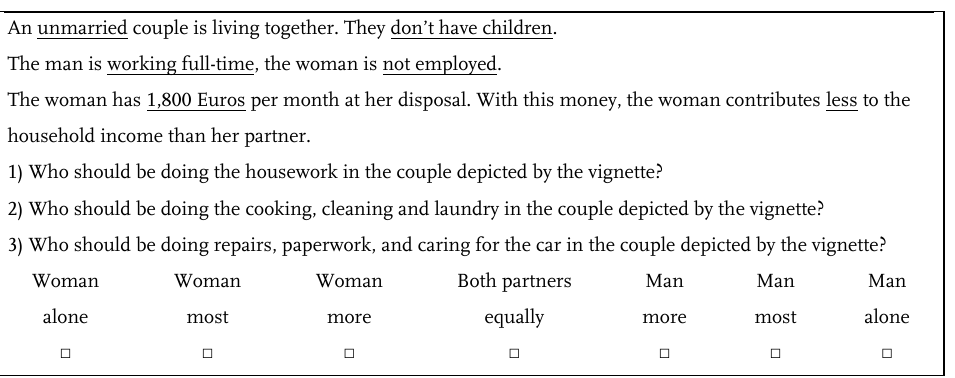
Figure 1 : Vignette